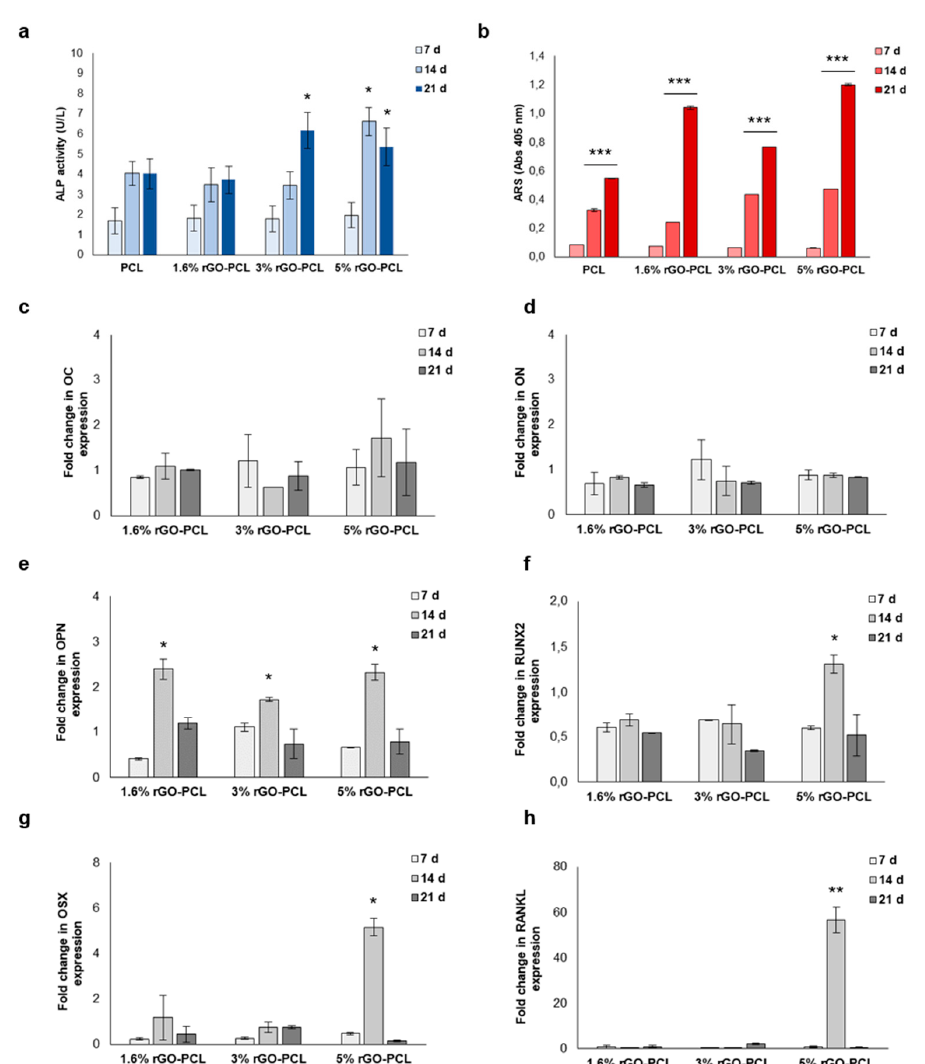
Figure 5. Differentiation of HMSCs towards osteoblast phenotype on rGO-PCL scaffolds up to 21 days. ALP activity ( a ). Quantification of mineral matrix deposition ( b ). Gene expression profile of osteogenic markers: osteocalcin ( c ), osteonectin ( d ), osteopontin ( e ), runt-related transcription factor 2 ( f ), osterix ( g ), receptor activator of NF-kB ligand ( h ). Data are expressed as mean ± SD. Multi comparison statistical analysis were performed by using one-way ANOVA. T test was to perform all pairwise comparisons between group means. Note: * p < 0.05, ** p < 0.01 and *** p < 0.001 mark significant changes compared to pure PCL at each time point.